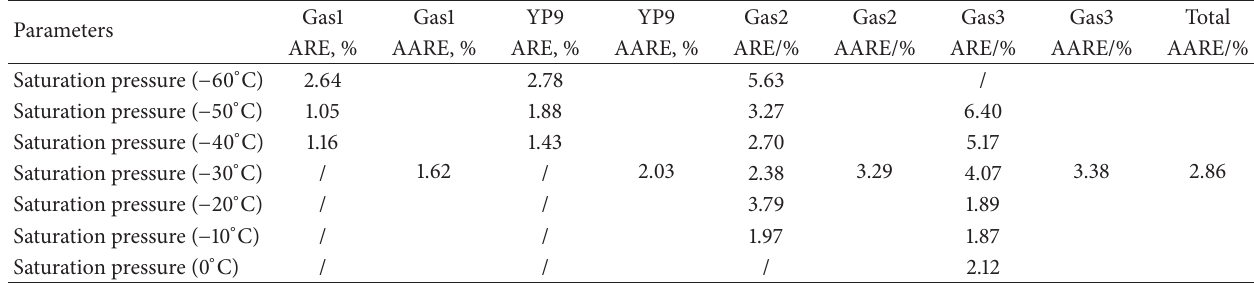
Table 5: The deviations between the saturation pressure calculated by using the model proposed in this paper and experimental measured saturation pressure.